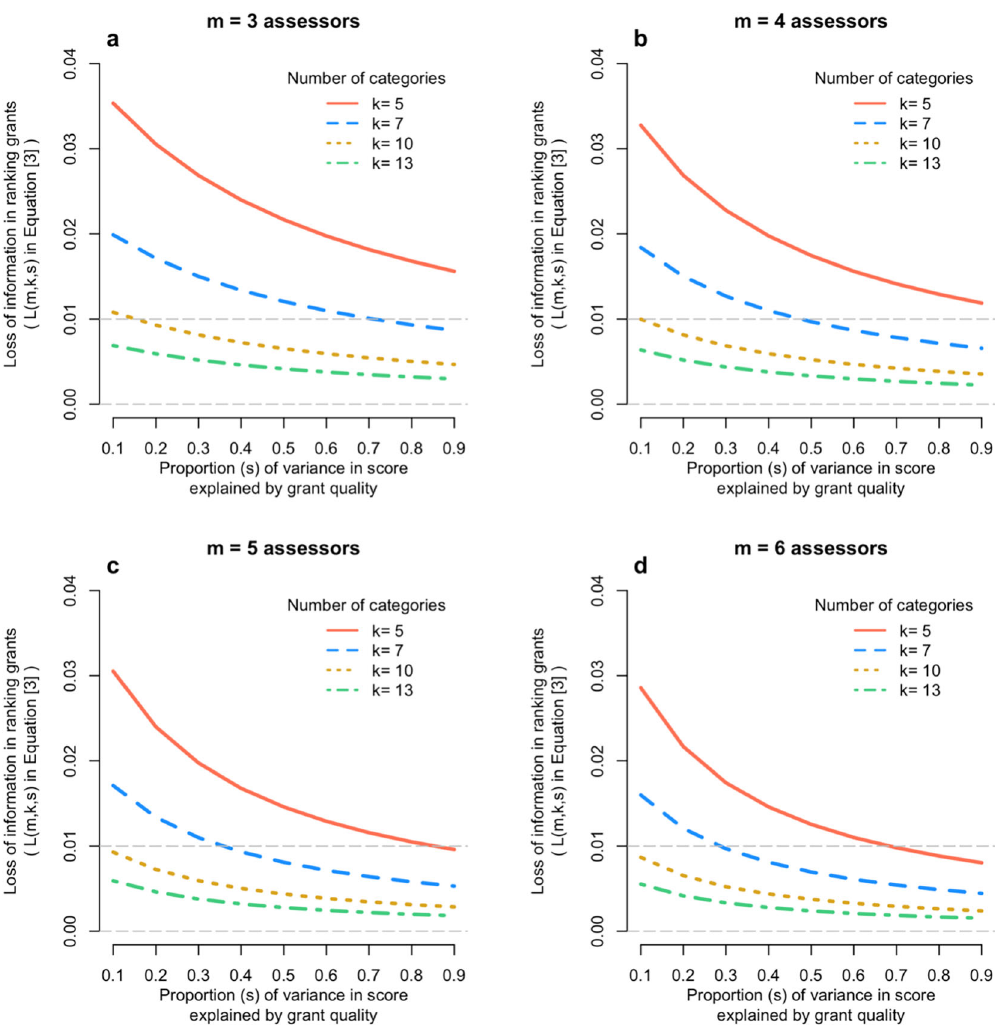
Figure 3. Loss of information relative to scoring on a continuous scale. Each panel shows the loss of information (Equation [3]) when scoring a finite number of categories relative to the continuous score, as a function of the number of assessors (panels a to d) and the proportion of variation in scores due to the quality of the grant (x-axis).